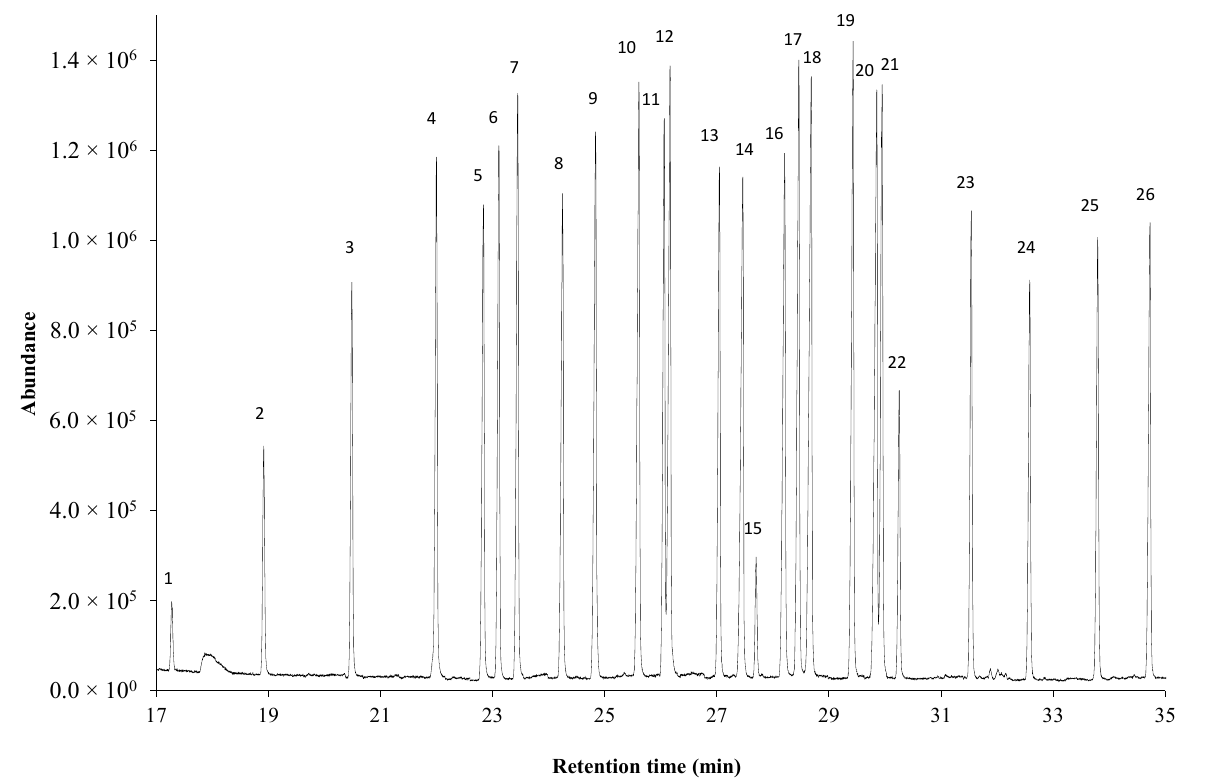
Figure 1. Total ion GC-MS chromatogram of BAME CP Mixture using the ionic liquid-based SLB- IL111 column. The peak labels represent components listed in Table 1 according to the retention order. The optimized experimental conditions are given in Section 4. The total FAME concentration is 0.5 mg mL − 1 .